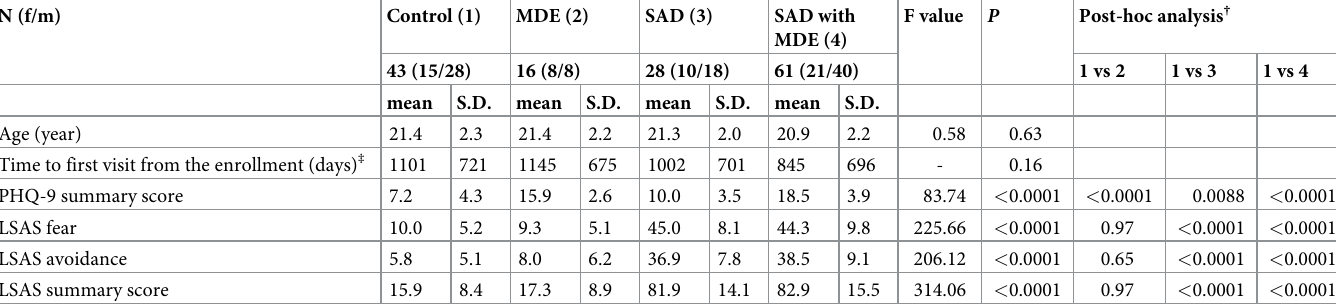
Table 1. Characteristics of each group at the first visit of the health care center. N